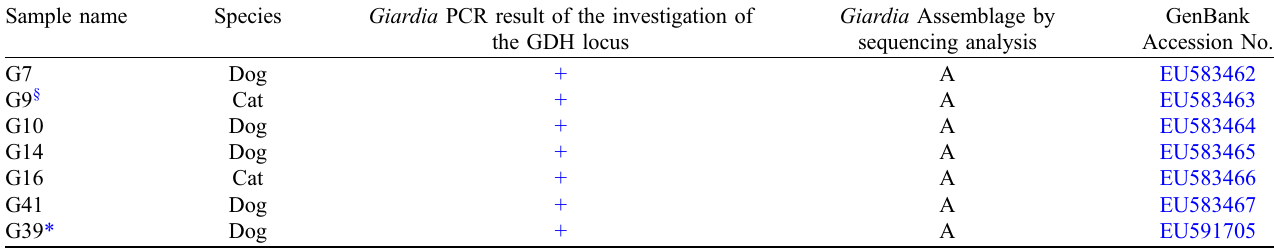
Table 1. Positive household animals for Giardia infections by PCR of the GDH locus, sequencing analysis results and accession numbers ( n = 19 cats and n = 81 dogs).